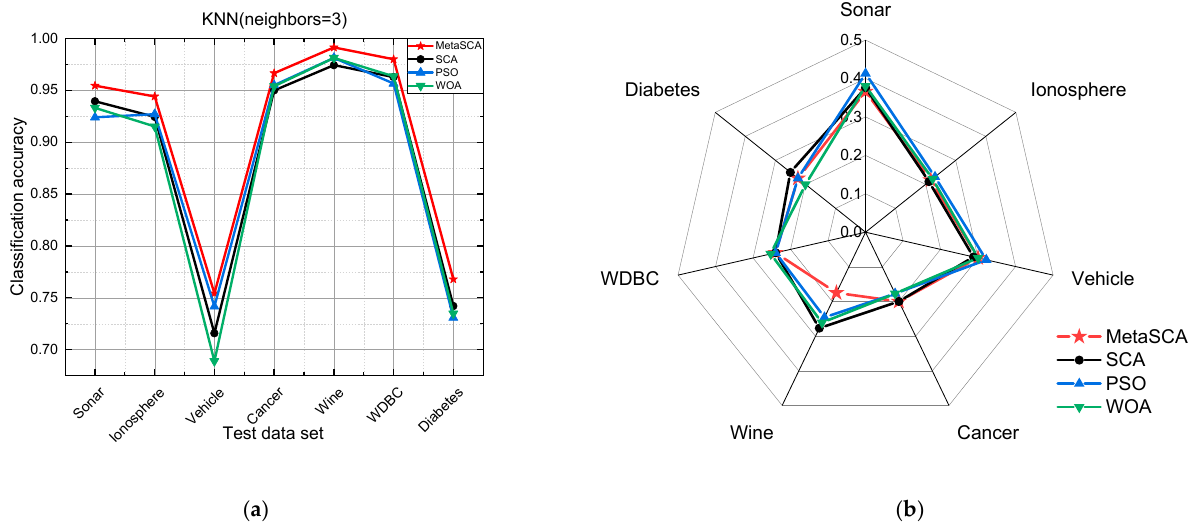
Figure 7. Classification accuracy and feature selection ratio (KNN, neighbors = 3). ( a ) comparison results of classification accuracy; ( b ) comparison results of feature selection rate.